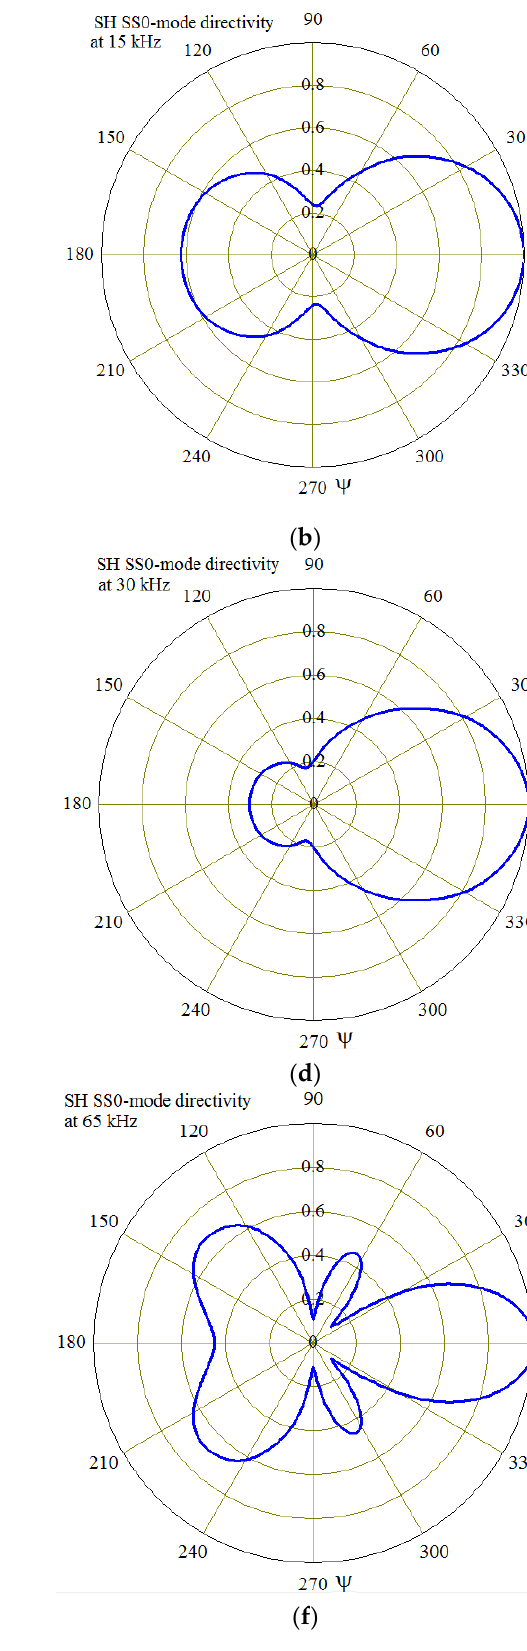
Figure 8. The normalized directivity diagrams for the Lamb A0 waves ( a , c , e ) and for the horizontally polarized SS0 waves ( b , d , f ) at the modeled eigenfrequencies of actuator: 15 ( a , b ), 30 ( c , d ) and 65 kHz ( e , f ).